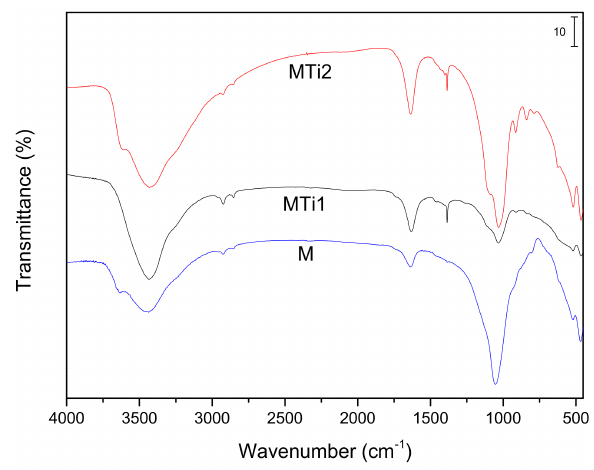
Figure 3. FT–IR spectra for the dried solids.